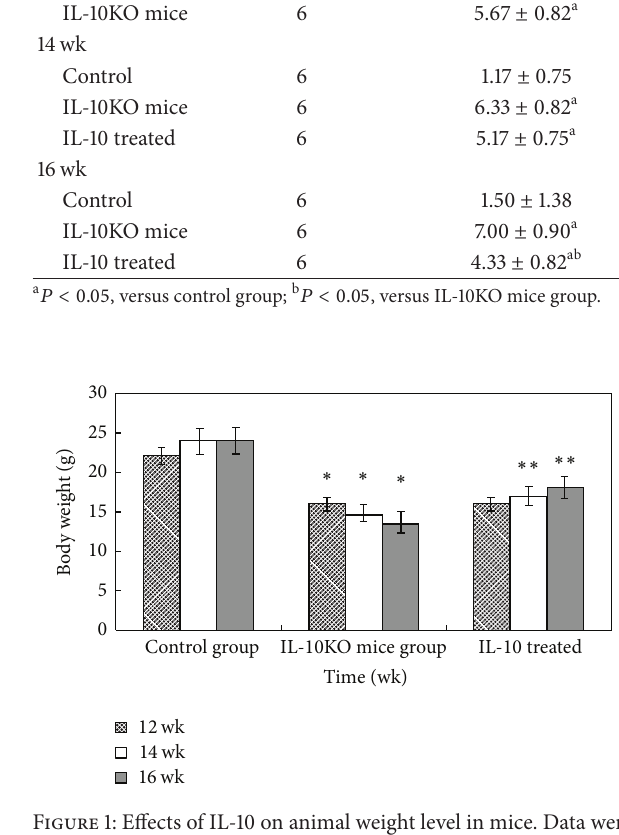
Figure 1: Effects of IL-10 on animal weight level in mice. Data were expressed as mean of weight values ± SD of 6 mice in each group. ∗ 𝑃 < 0.05 compared with control group; ∗∗ 𝑃 < 0.05 compared to the IL-10KO mice